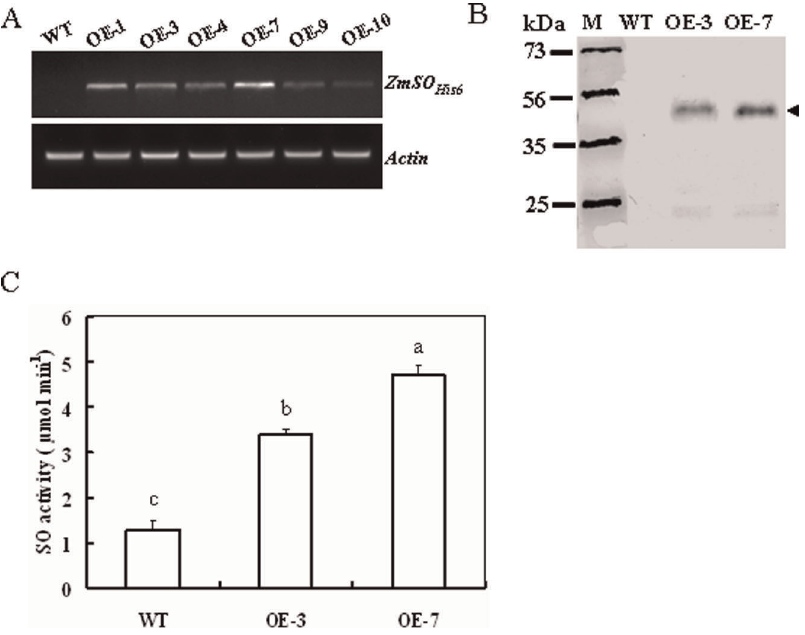
Figure 2. Expression levels and activity of ZmSO in SO-modified tobacco plants. (A) Transcription levels of the ZmSO-His 6 in wild-type tobacco plants and six homozygous over-expression (OE) lines (named OE-1, OE-3, OE-4, OE-7, OE-9, and OE-10). ZmSO transcripts detected by semi- quantitative RT-PCR were present in the OE lines, but not in the wild-type plants. Moreover, the ZmSO transcript level was highest in OE-7 among the six over-expression lines. (B) Western blot analysis of wild-type and OE lines (OE-3 and OE-7). Proteins (20 m g per lane) were fractionated by 12.5% SDS-PAGE and immunobloted with histidine tag-specific antibody. The protein level of ZmSO-His 6 was also relatively higher in OE-7 than that in OE-3. (C) Total SO activity in leaf extracts from wild-type and OE lines measured by kinetic assays. The total SO activity was significantly higher in the leaf extracts of OE-3 and OE-7 than in wild-type plants. Kinetics of SO activity was assayed using the ferricyanide reduction technique. The steady-state kinetics of ferricyanide reduction was followed spectrophotometrically at 420 nm using 10 g of protein extract.